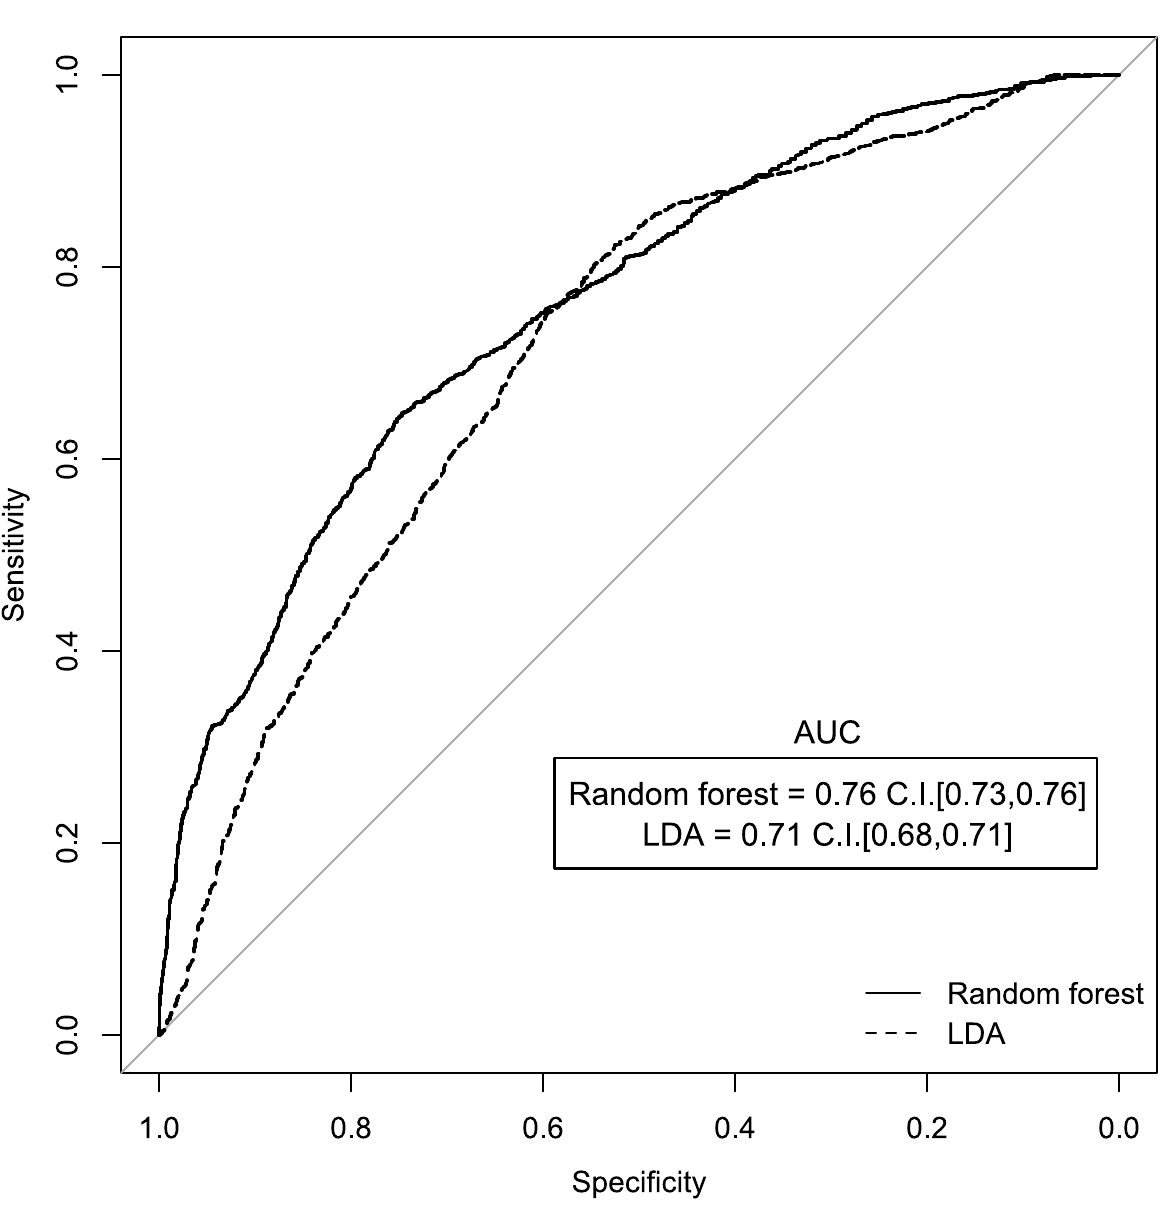
Fig 2. Receiver operating characteristic curve (ROC) for the random forest (RF) and linear discriminant analysis (LDA) models built using repeated double cross-validation to classify patients with prostate cancer and cancer-free controls based on PSA levels and VOCs in urine headspace.